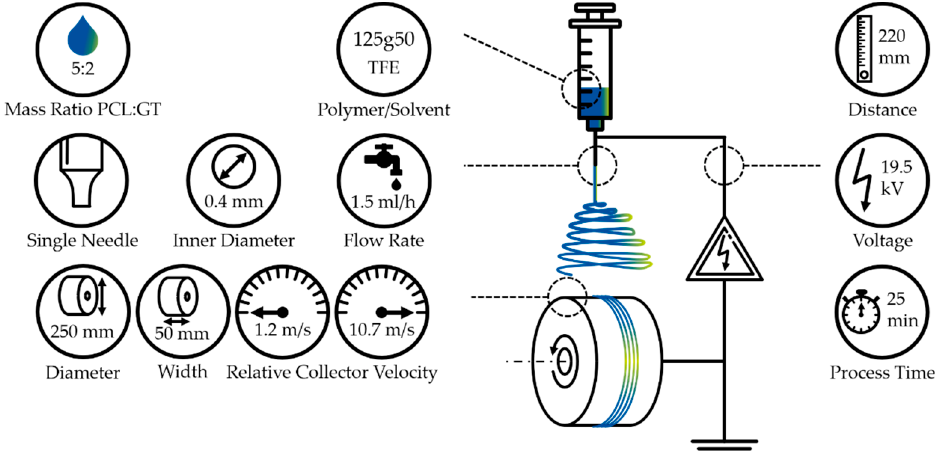
Figure 1. Overview of the experimental setup and adjusted process parameters. The electrospinning device used is composed of a grounded and rotating drum collector, high voltage supply, cannula, syringe and syringe pump. The adjusted parameters—the needle tip to collector distance, applied voltage, total process time, relative collector velocity, diameter and width of the drum collector, flow rate, inner cannula diameter, setup type, polymer and solvent as well as the mass ration of the used blend—are